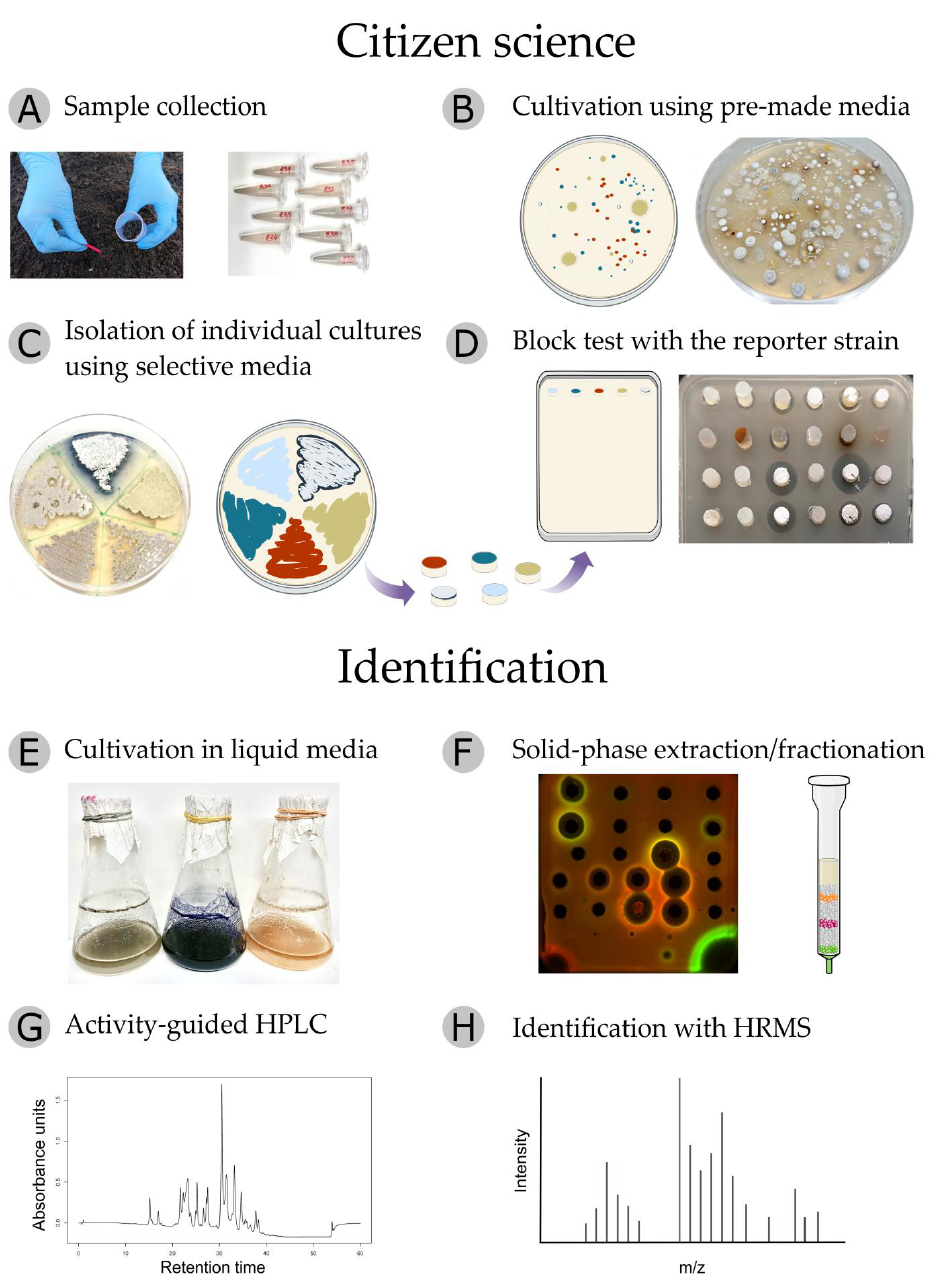
Figure 4. Workflow diagram of the Citizen Science project. ( A ) Soil sampling. ( B ) Isolation of individual actinomycete colonies through serial dilution. ( C ) Pure isolates are streaked onto different selective growth media. One extra plate is transferred to the Research Center. ( D ) Activity-guided selection of antimicrobial producers using agar block diffusion assay with the reporter strains. ( E ) Determination of optimal cultivation conditions. ( F ) Solid-phase extraction of culture liquid followed by fractions analysis using agar-well diffusion assay with the reporter strains. ( G ) Bioactive fractions are repeatedly subjected to reversed-phase HPLC separation. ( H ) Active pure HPLC peaks are analyzed with HRMS, revealing the exact mass of the antimicrobial